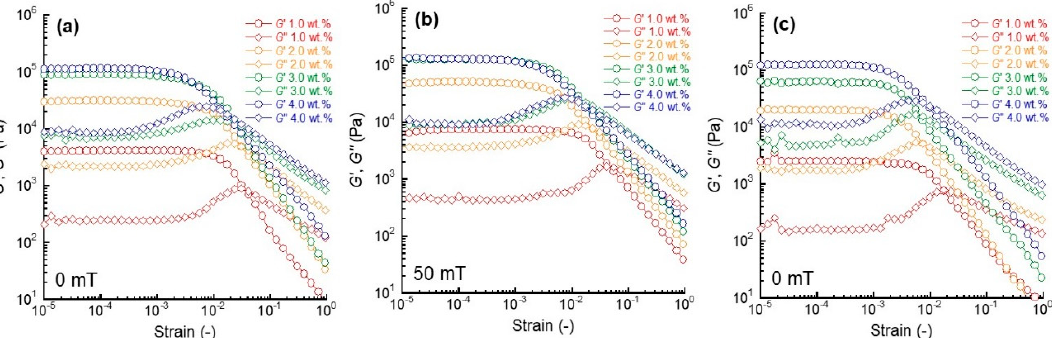
Figure 1. The strain dependence of the storage and loss moduli for magnetic gels with a concentration of 50 wt.% at ( a ) 0 mT and ( b ) 50 mT and for ( c ) the carrageenan gels without magnetic particles at 0 mT.